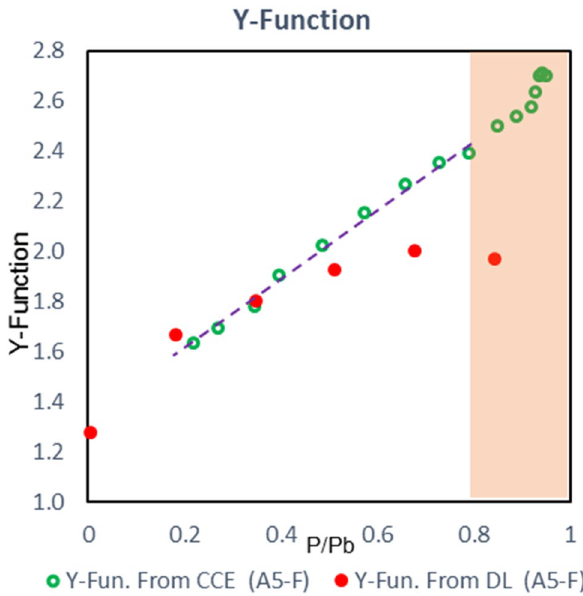
Fig. 26 Invalid trend of Y-function of DL